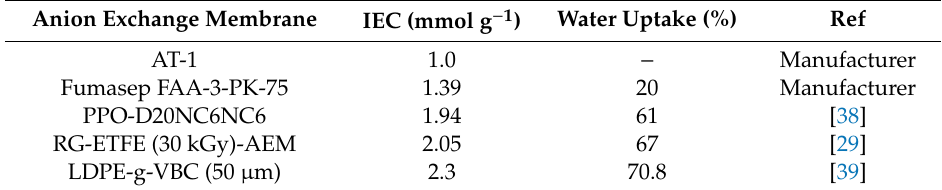
Ion exchange capacity (IEC) and water uptake of some selected anion exchange membranes